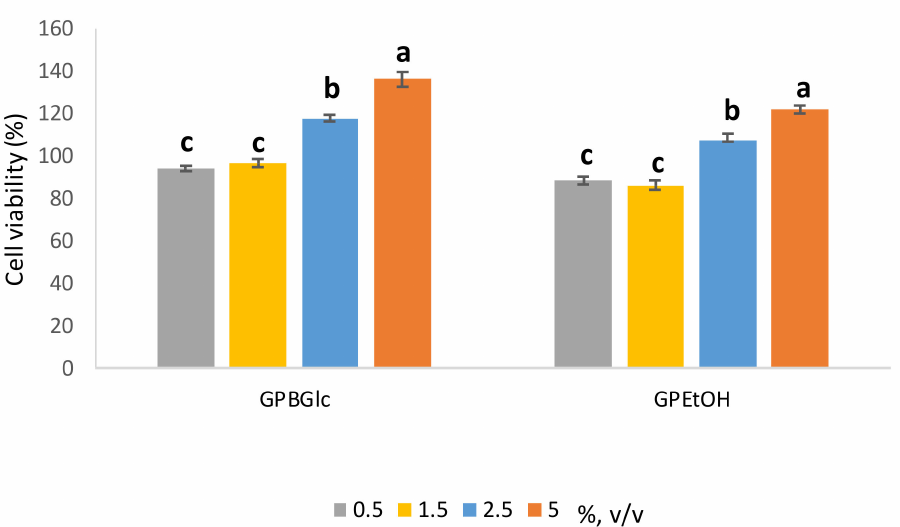
Figure 3. Effect of prepared extracts on HaCat cell viability determined by the MTS assay was assessed in volume ratio 0.5–5% ( v / v ). Cell viability (%) was expressed as percentage of treated cells versus control cells and the data from 3 individual experiments were expressed as the means ( n = 4) ± S.D. Presented values followed by different lower-case letters (a–c) are significantly different ( p < 0.05) as measured by Tukey’s HSD